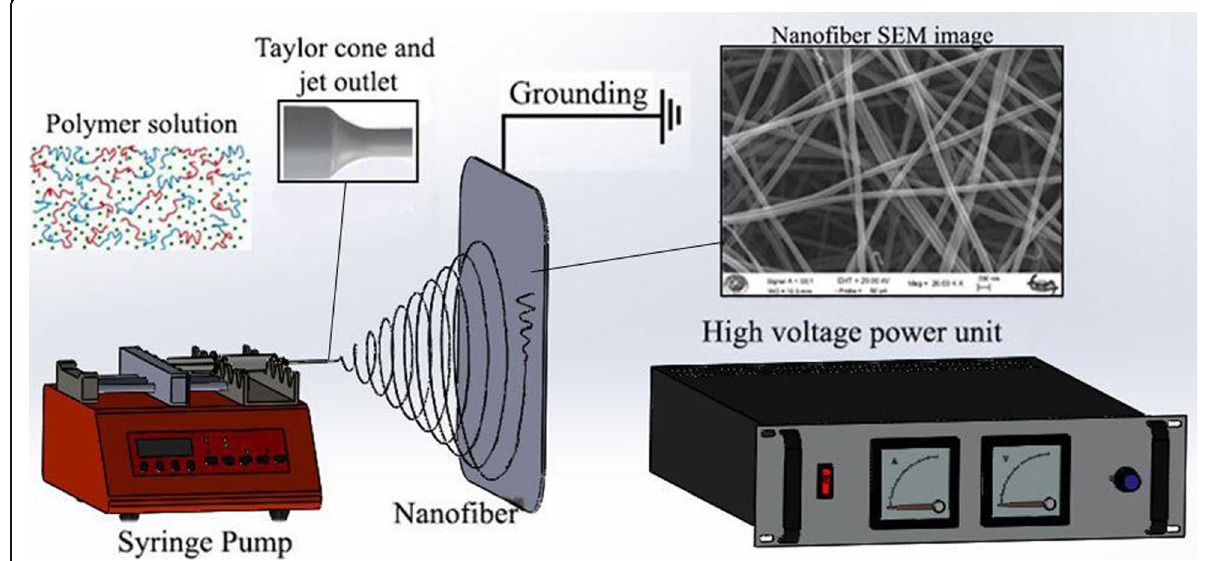
Fig. 2 Nanofiber production with electrospun method (graphene added N6,6